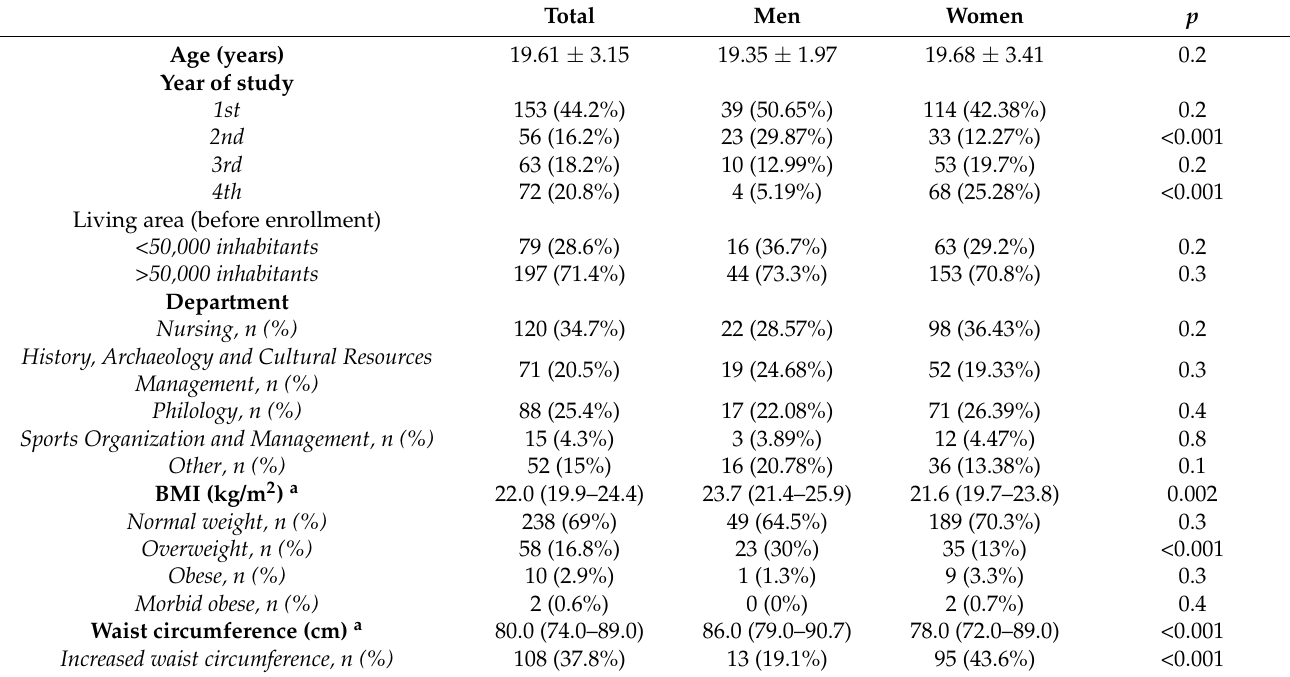
Table 1. Descriptive characteristics of